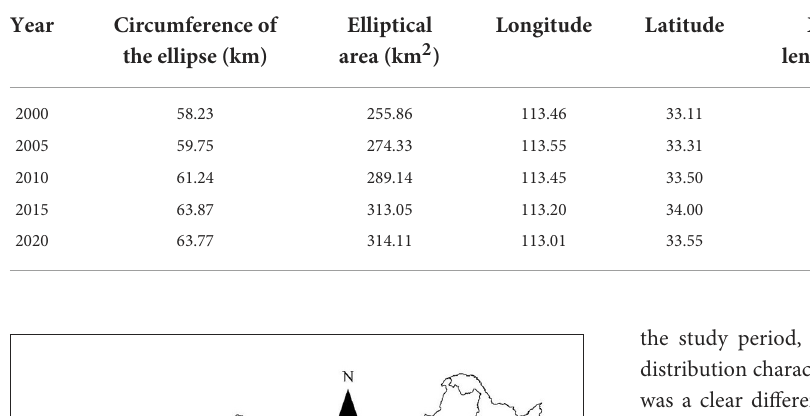
TABLE 4 Basic information of standard deviation ellipse analysis.